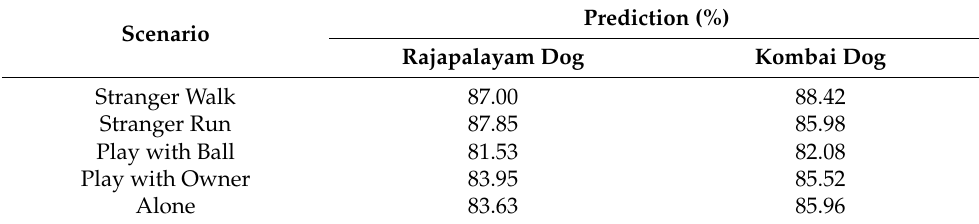
Table 4. Overall prediction level.